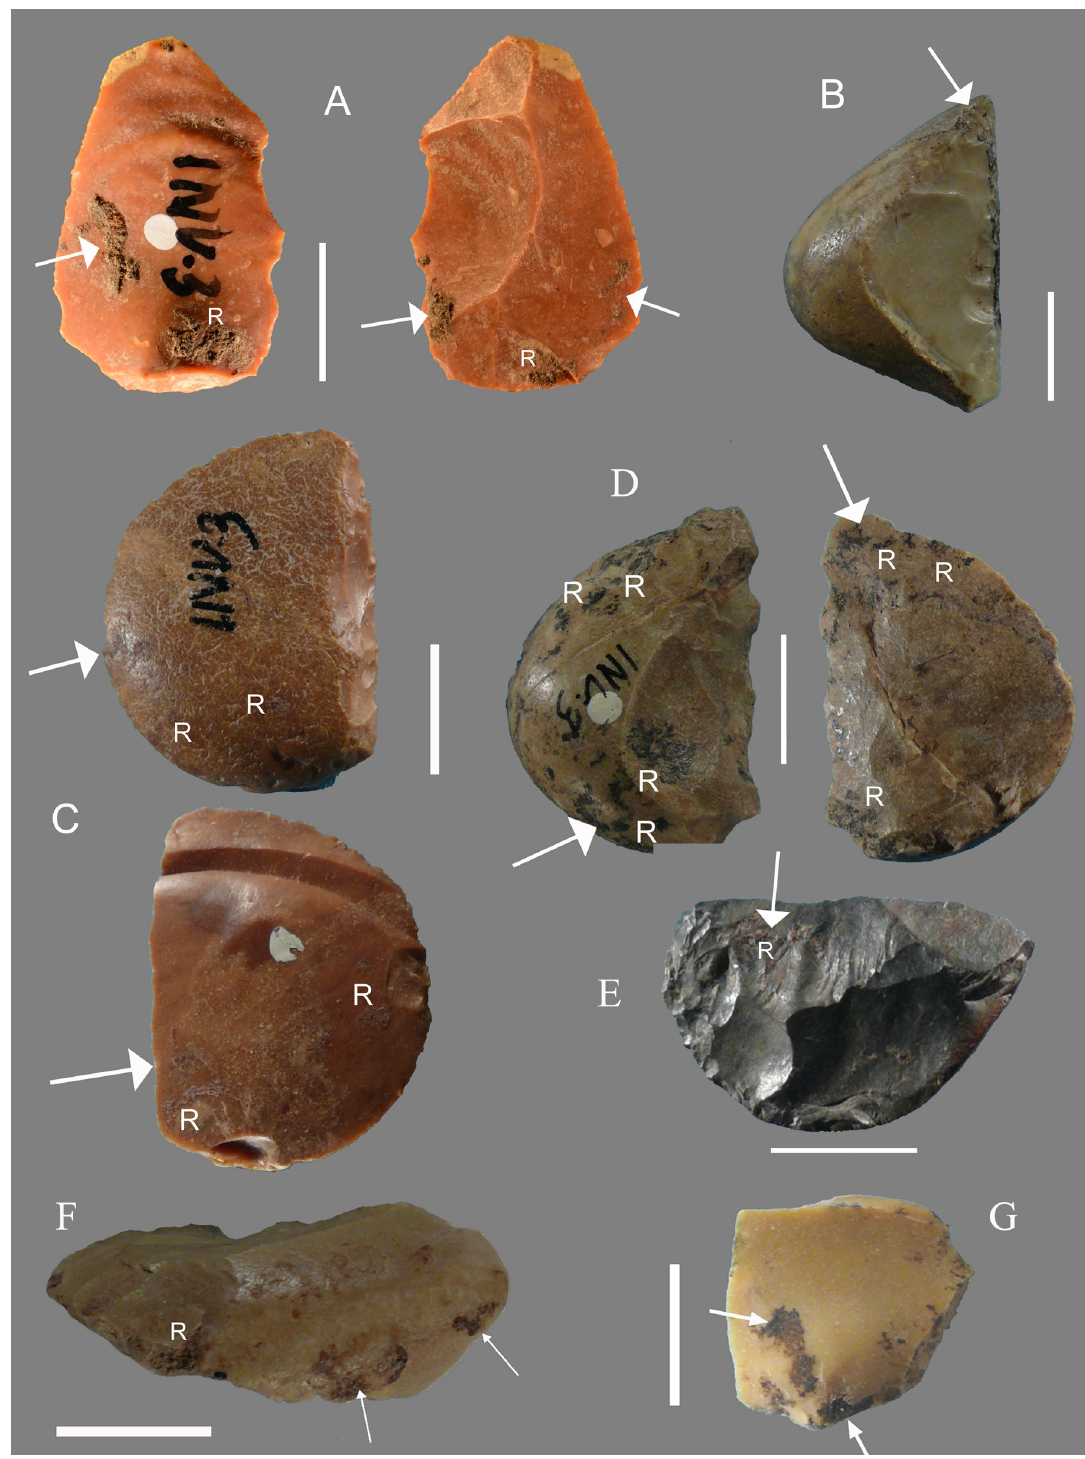
Fig 6. Stone tools with analyzed residue from Sant’Agostino cave, layer A1, all tools are of flint. The white arrow indicates the analyzed sample; R indicates macroscopically visible residue. (A) Levallois flake no. L2; (B) transverse scraper no. 362, oriented according to the morphological axis; (C) Side scraper no. 114; (D) Side scraper no. 258; (E) Scraper no. 211; (F) Transverse scraper no. 268; (G) Small unretouched flake, catalogue no. M1. All pieces gave significant results with the exception of (G). Scale bar = 1 cm.